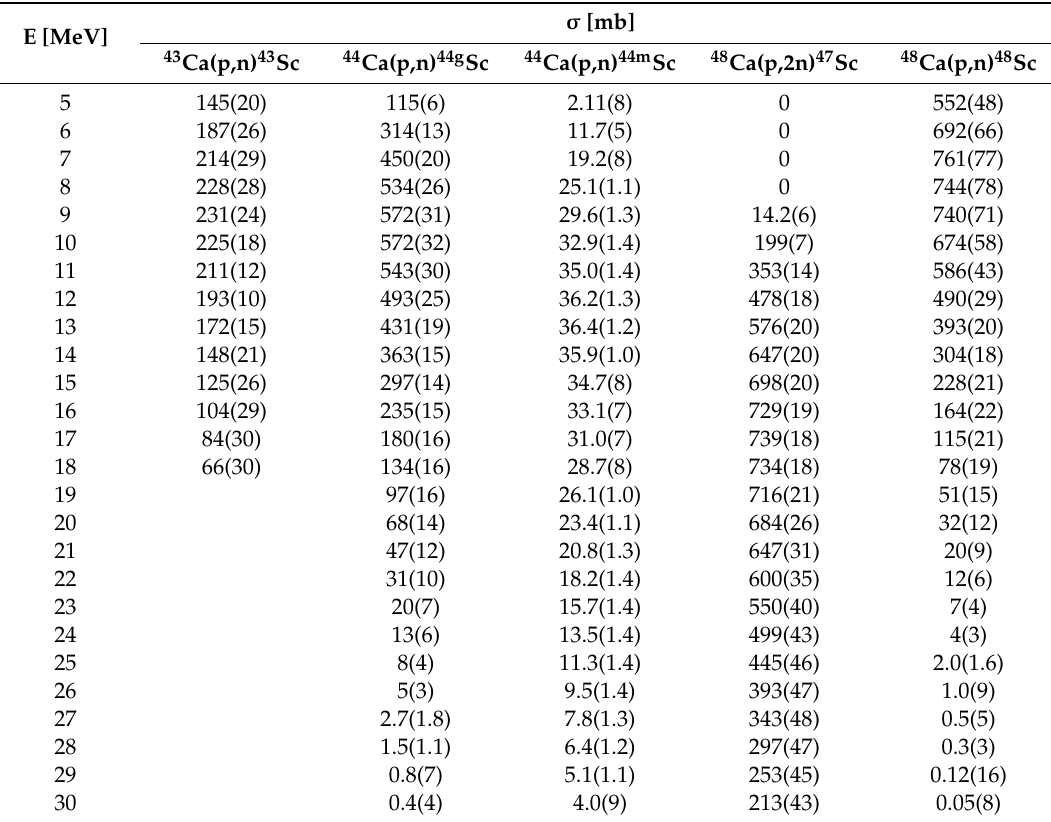
Table 3. Cross-section values for di ff erent nuclear reactions deduced from the thick target yield data from